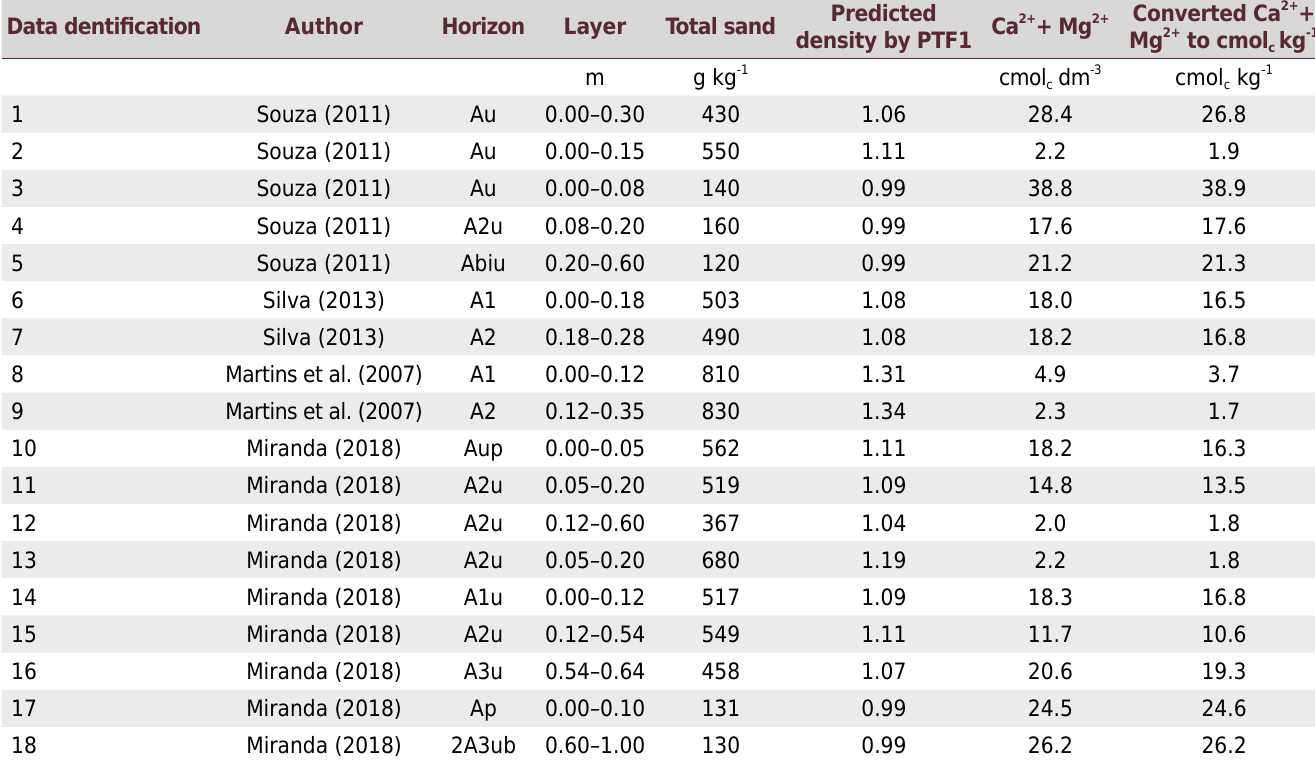
Table 5. Data from literature of calcium plus magnesium (Ca 2+ +Mg 2+ ) in the volumetric base converted to the gravimetric basis through PTF1 Data